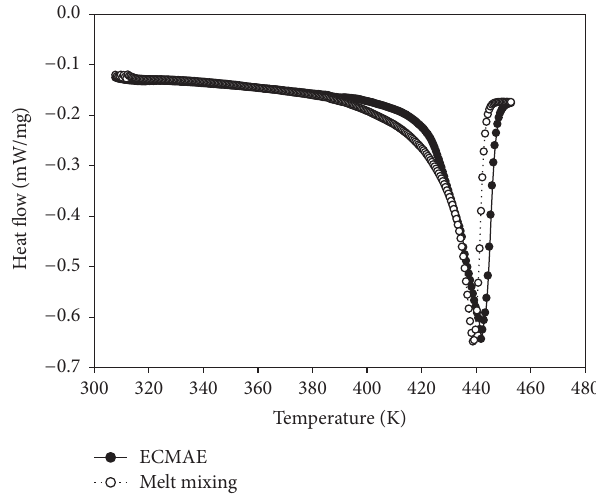
Figure 6: DSC traces for specimens of PP-OMMT.